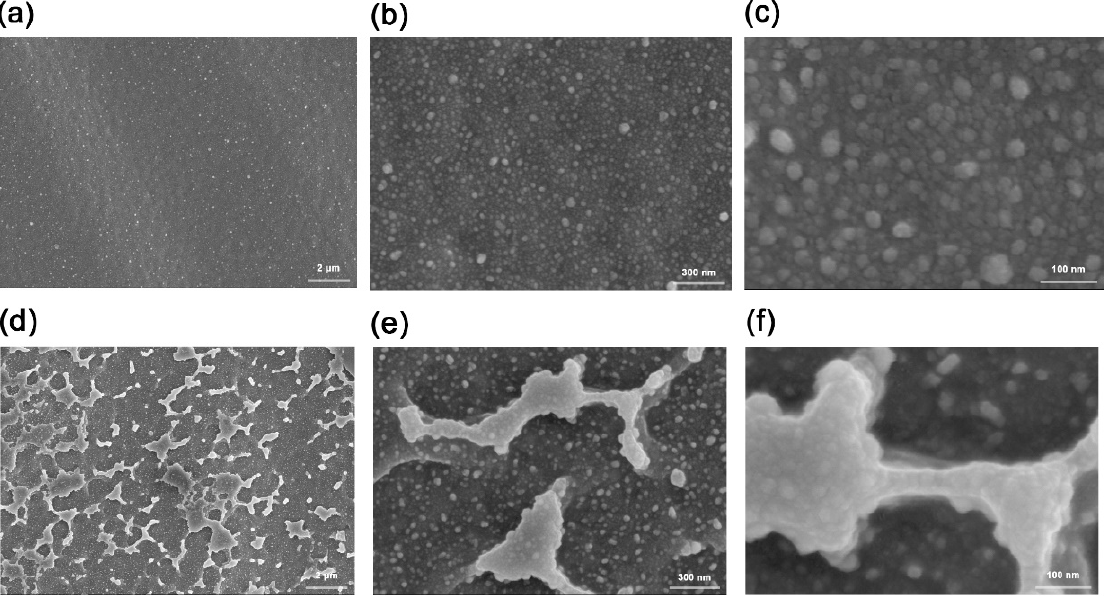
Figure 8. ( a – c ) The 10 K, 60 K, and 200 K SEM photographs of sample 3. ( d – f ) The 10 K, 60 K, and 200 K SEM photographs of sample 1 and sample 4.